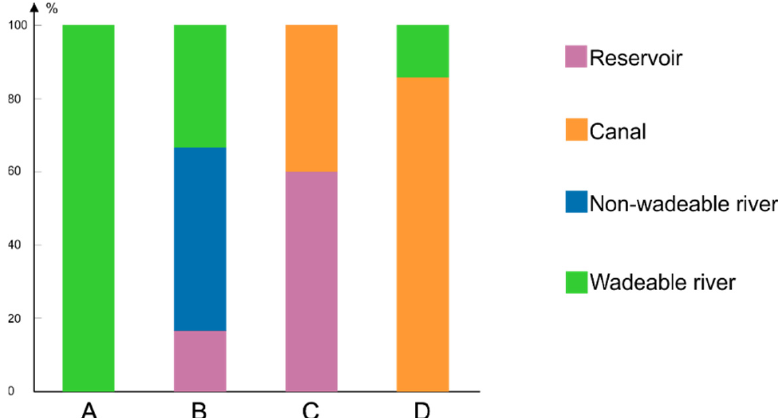
Figure 4. Occurrence (in percentage) of different chironomid assemblage types in four types of waterbodies. Four assemblage types (obtained through K-means clustering) are in capital letters A, B, C, D coloured as indicated.